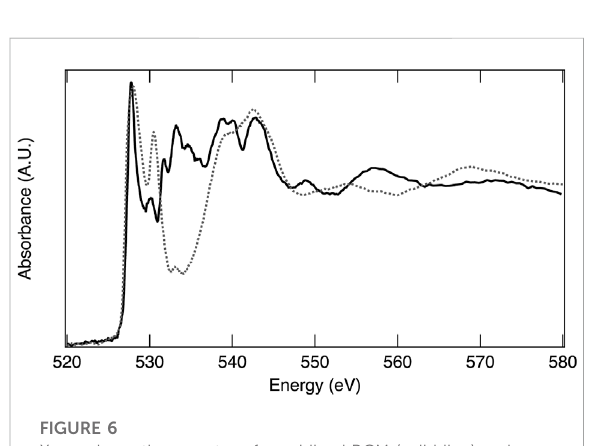
FIGURE 6 X-ray absorption spectra of reoxidized BCM (solid line) and MnO 2 (dashed line) at the O K-edge.